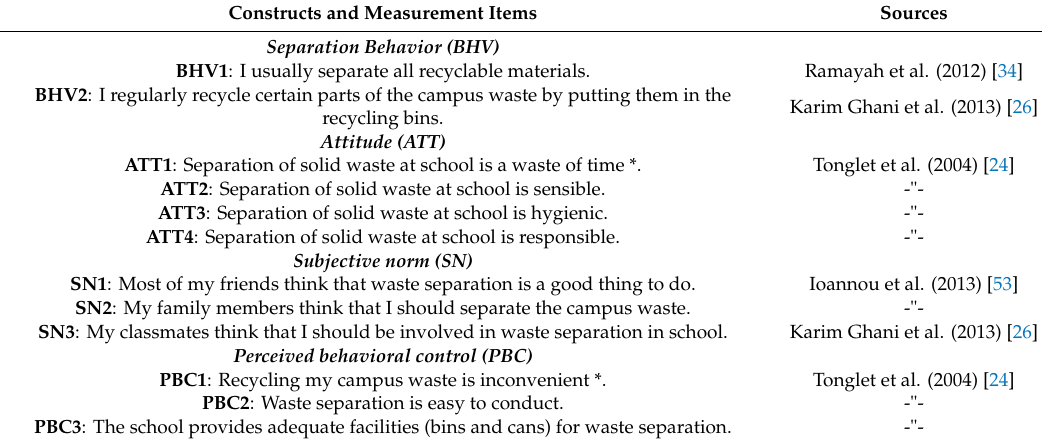
Table 1. Constructs, measurement items, and